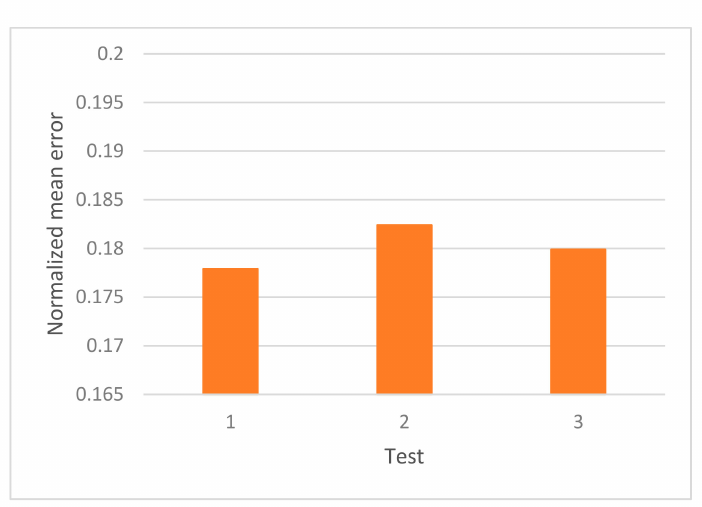
Figure 8. Normalized mean error over the multilayer tests from Table